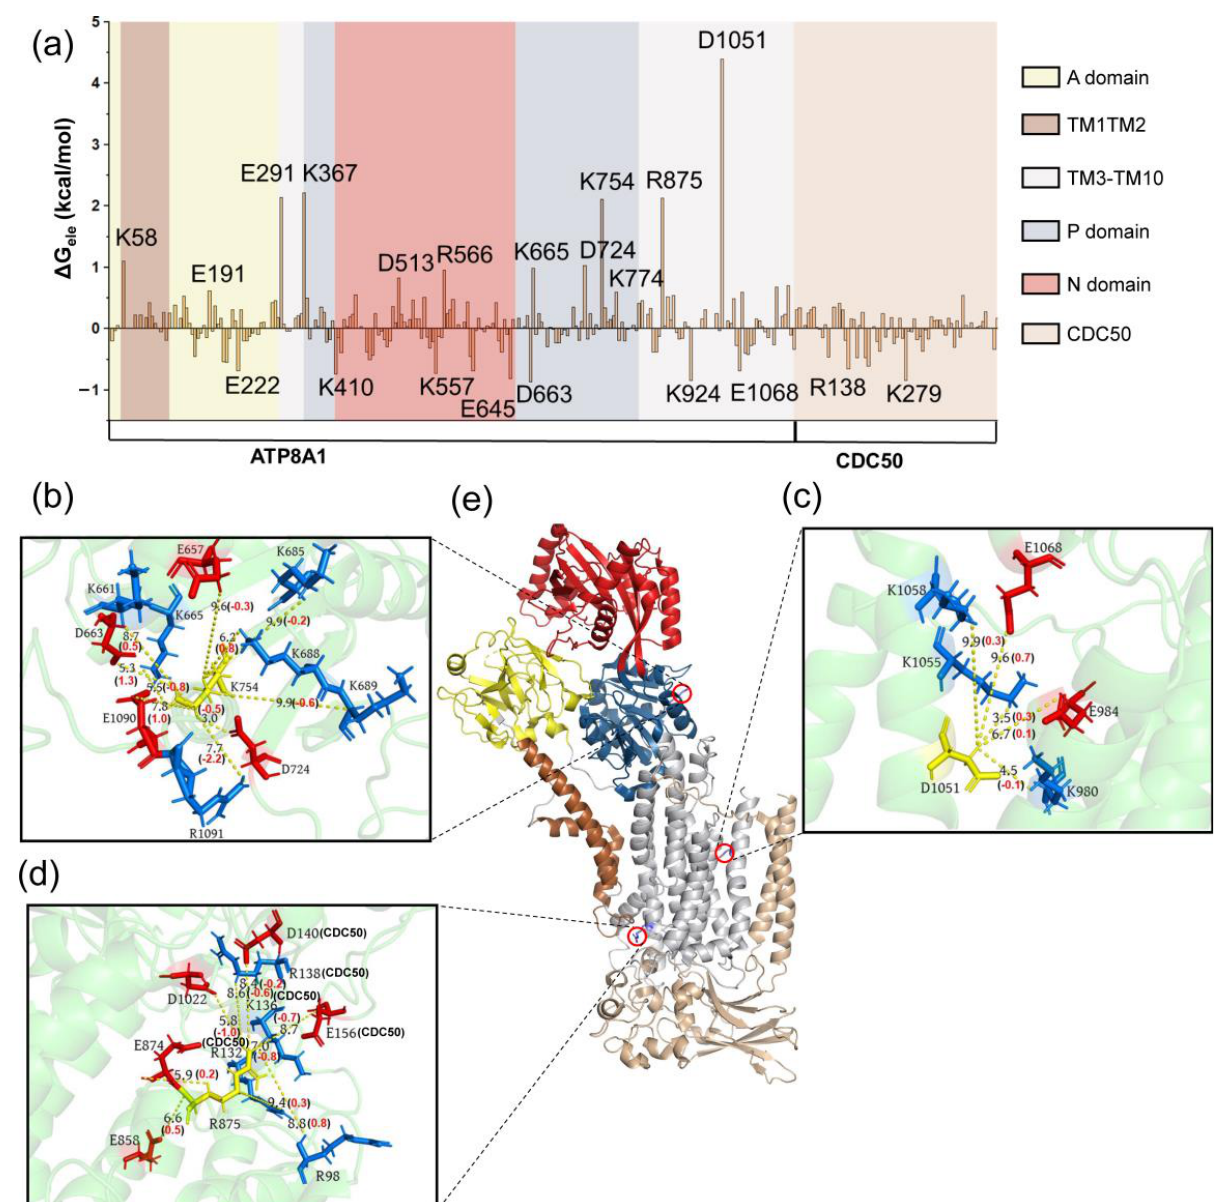
Figure 3. ( a ) The electrostatic contribution of residues for structures I1 and T1. The values in parentheses indicate the distance changes in specific residues in the T1 and I1 structures. The interaction map of K754 ( b ), D1051 ( c ), R875 ( d ) and their corresponding position in the P4-ATPase ( e ). The positively charged residues are colored blue, and the negatively charged residues are shown in red. The values in parentheses are the distance difference between the T1 and I1 structures.